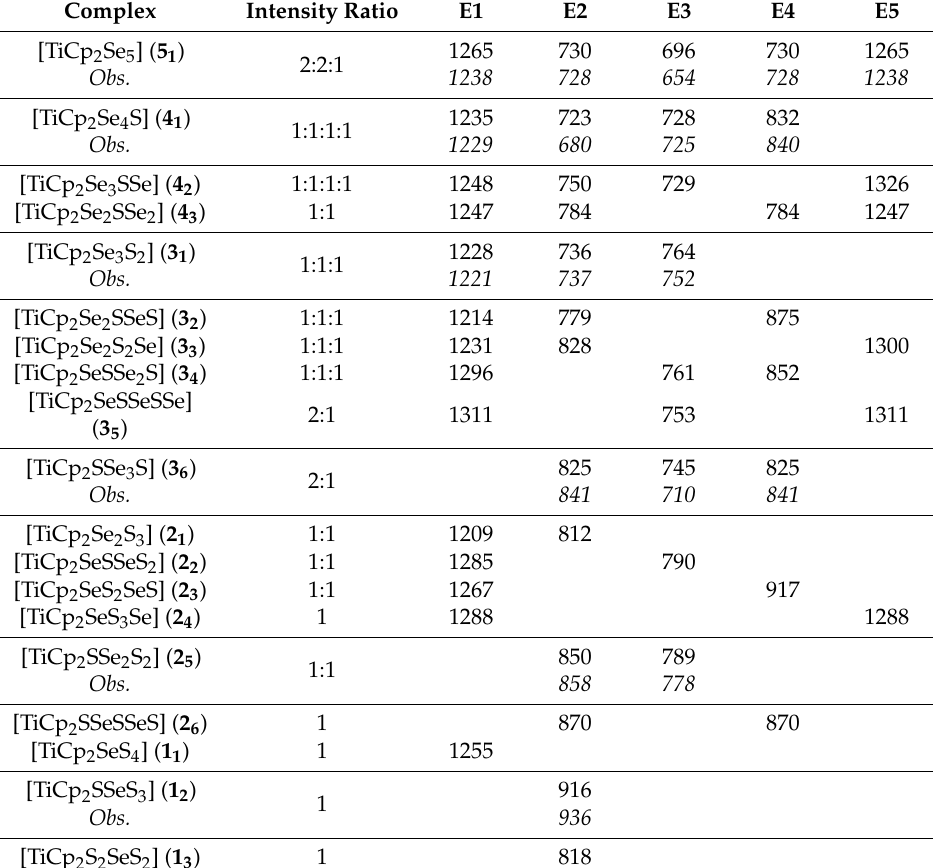
Table 1. Computed and observed chemical shifts of [TiCp 2 Se x S 5 − x ] a .